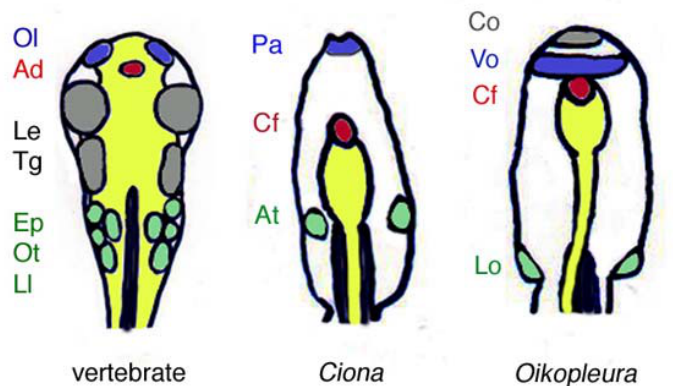
FIGURE 3 . Comparison of vertebrate, C. intestinalis, and O. dioica placodes during development. Anterior is up for all animals. The homology between vertebrate and urochordate has been established on the basis of molecular, cellular, and morphological data. The Ciona palps (blue) and the Oikopleura ventral organ are considered homologous to the vertebrate olfactory placodes. The ciliated (or ciliary) funnel of the urochordates is homologous to the adenohypophysis, while the atrial placodes ( Ciona ) and the Langerhans organs primordia ( Oikopleura ) are homologous to the otic and, possibly, the lateral line placodes. The expression of Ci-phox2 in the atrial primordia might suggest that the vertebrate epibranchial placodes originate from the same posterior protoplacode than otic and lateral line placodes. No evidence of homology has been found so far for vertebrate lens and trigeminal placodes. The relation of the Oikopleura ventral organ is unclear. The central nervous system is labelled in yellow. Placodes labelled in grey do not seem to have homologous structures in other animals. Notochord is in black. Ad: adenohypophyseal, At: atrial primordium, Cf: ciliated funnel, Co: circumoral organs, Ep: epibrnchial, Le: lens, Ll: lateral line, Lo: Langerhans organs, Ol: olfactory, Ot: otic, Pa: palps, Tg: trigeminal, Vo: ventral